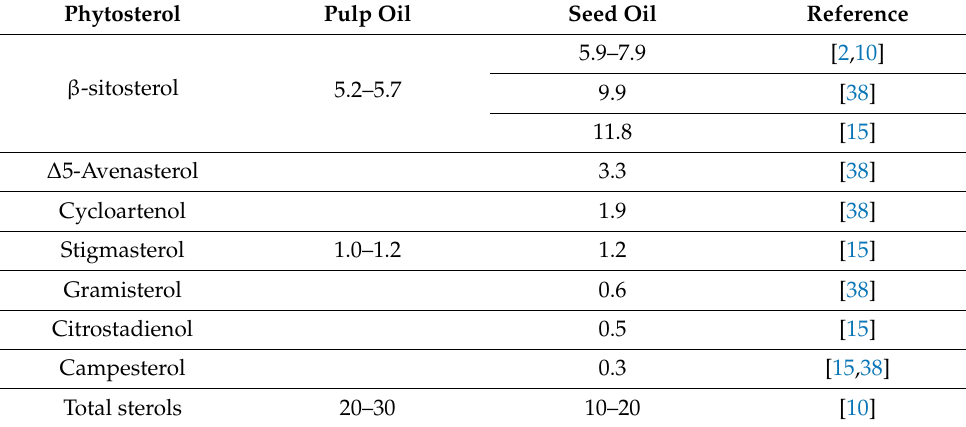
Table 2. Phytosterols content in sea buckthorn pulp and seed oil, (g/kg of fresh weight). Phytosterol Pulp Oil Seed Oil Reference β